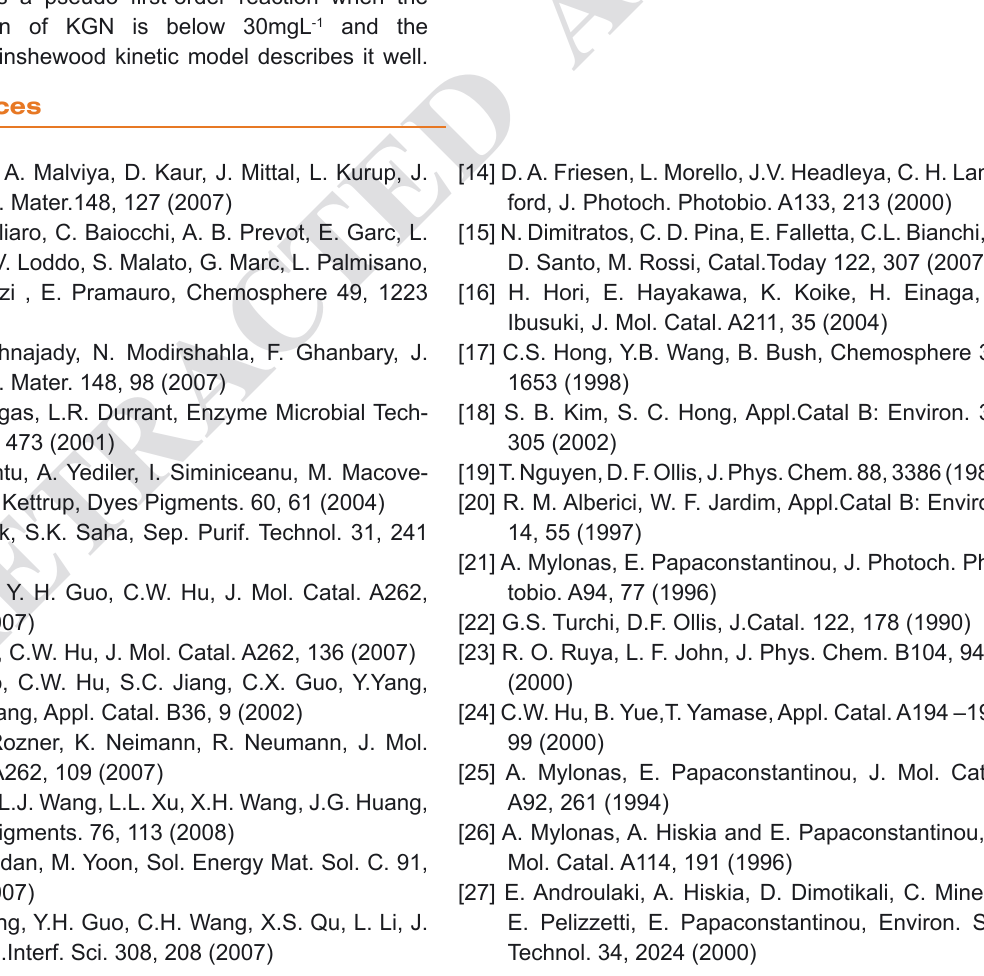
-0.010-0.008-0.006-0.004-0.0020.000 A U nm200.00 250.00 Figure 10. The UV-Vis spectrum of KGN at 1.888 after 2 h of ir- radiation with TiO